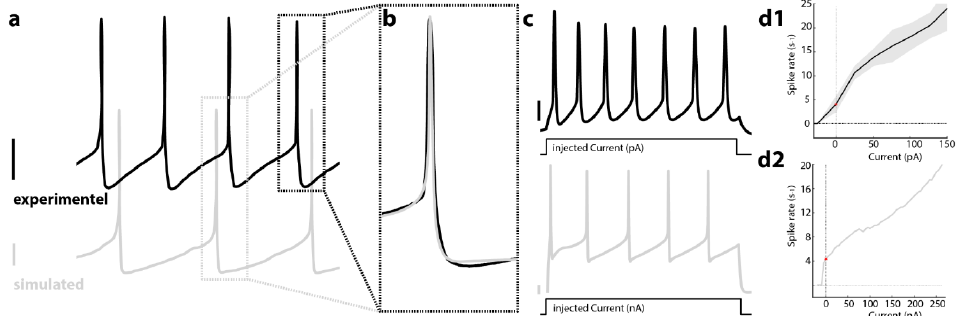
Figure 3. LC neuron model recapitulates essential spontaneous spiking, action potential characteristics, and current-evoked frequency dependency. ( a ) Spontaneous neuronal spiking in an LC neuron recorded in an acute brain slice from P70 mice via whole-cell patch-clamp (upper black trace). Action potentials show typical long after-hyperpolarization (AHP) that gave rise to a 4.2 Hz spontaneous spiking rate. Trace below shows simulated LC neuron that exhibit a similar spontaneous spiking rate and slow AHP. ( b ) Overlay of experimental and simulated action potentials exhibit a similar temporal profile. ( c ) The current-evoked increase in membrane potential evokes a barrage of action potentials in a recorded and simulated neuron (300 ms current injections). ( d1 ) Illustrates the spike rate of recorded LC neurons under different current step amplitudes (error margin as SEM; n = 12 cells, 2 animals); ( d2 ) Simulated LC neurons exhibit an increase in spike rate for different amounts of injected current. Note the different current units in ( d1 , d2 ) due to the different cell sizes of experimental and simulated neurons. Scale bars 10 mV for experimental neurons and 20 mV for simulated